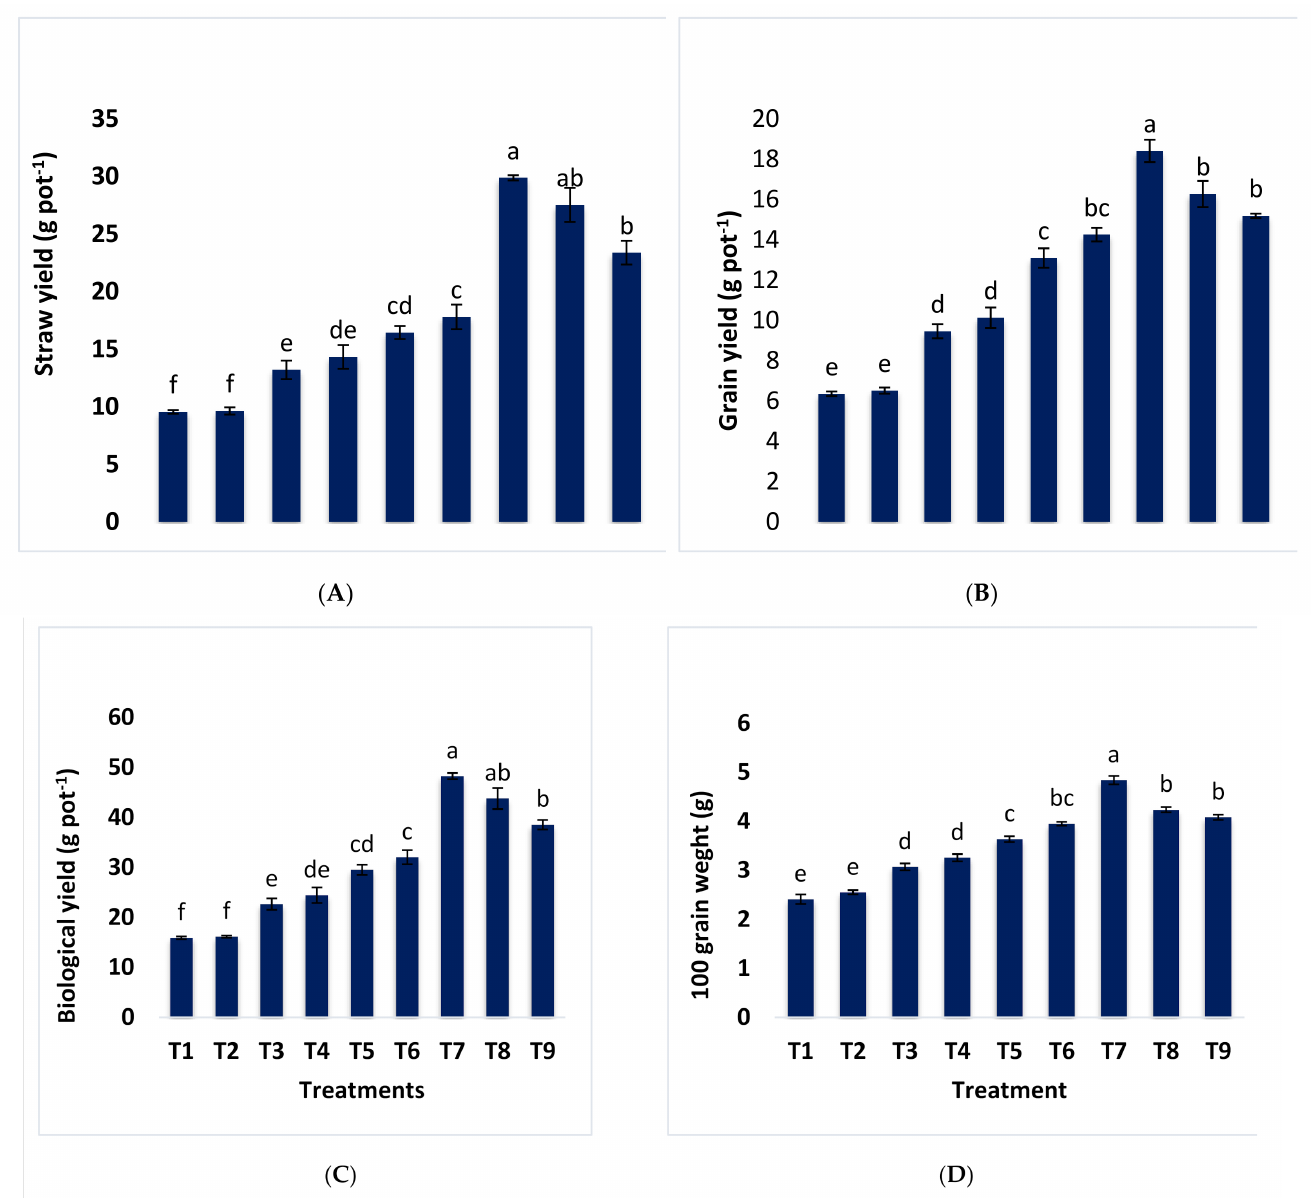
Figure 2. Effect of different combinations of B-RP and DAP on straw yield ( A ), grain yield ( B ), biological yield ( C ) and 100 grain weight ( D ) of wheat. Bars sharing similar letters do not differ significantly at P < 0.05; The standard error (SE) represents variation of population mean from sample mean ( n = 3); T1: Control (0% P), T2: RP (100% P), T3: AM (100% P), T4: PM (100% P), T5: B-RP (100% P), T6: B-RP (75% P) + DAP (25% P), T7: B-RP (50% P) + DAP (50% P), T8: B-RP (25% P) + DAP (75% P), T9: DAP (100% P). RP: Rock phosphate, AM: Animal manure, PM: Poultry manure, B-RP: Bio-activated rock phosphate, DAP: Diammonium